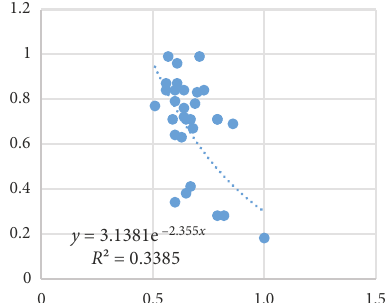
Figure 2. Results of the correlation-regression Figure 3. Results of correlation-regression analy- sis of the impact of economic development in- analysis on the impact of economic develop- ment intensity on ots integrity in EU when non- tensity on EU in the case when context of other contextualising other countries applies (source: countries is considered (source: compiled by compiled by the authors)